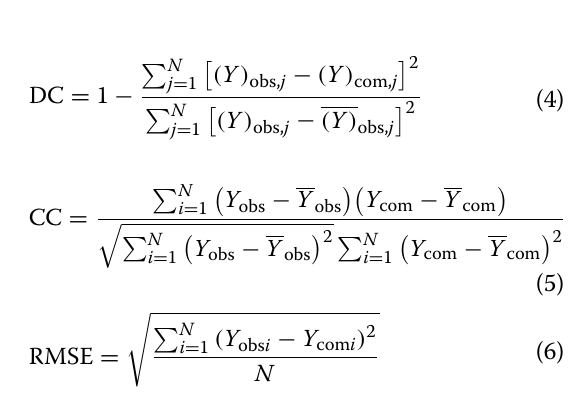
Fig. 3 Scatter plots for d MLP, e ANFIS and f SWLR for 1L-6